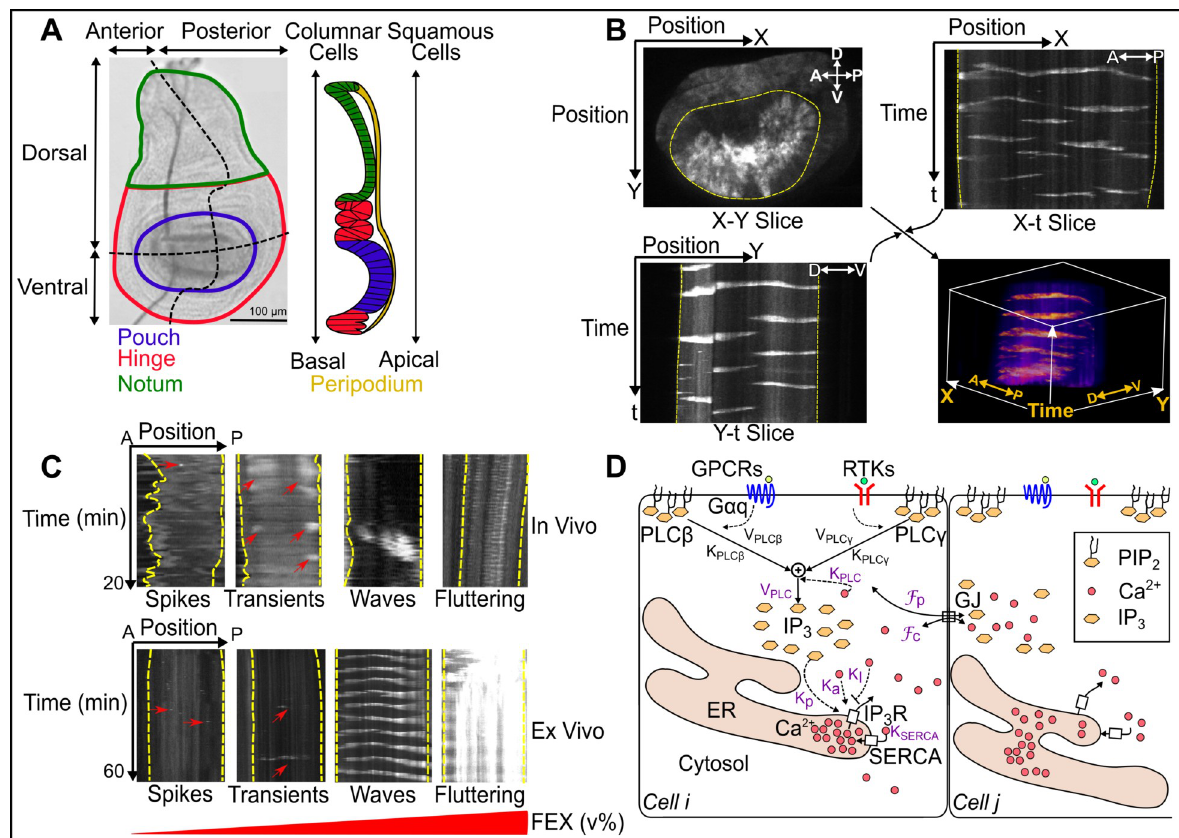
Fig 1. Multicellular Ca 2+ signaling in a developing organ. (A) ( Left panel ) Image of third instar Drosophila wing imaginal disc. The larval wing disc includes main four regions: pouch (blue), hinge (red), notum (green) and peripodium (yellow). The pouch cells are the region of interest for this study. ( Right panel ) A schematic of the side view of the wing disc showing the peripodial membrane composed of squamous epithelial cells. (B) Kymographs illustrate two-dimensional slices of three-dimensional (X, Y and t planes respectively) spatiotemporal signaling. Ca 2+ signaling activity is related to the fluorescence intensity of the Ca 2+ sensor, GCaMP6f. A view of the X-Y plane (top left), the X-t plane (top right), and Y-t plane (bottom left) are combined to illustrate a 3D view of the signaling activity (bottom right). Yellow dashed lines indicate the pouch region. X coordinates roughly correspond to the A/P direction of the wing disc pouch whereas the Y coordinate principally describes the D/V axis of the pouch. (C) Four classes of Ca 2+ signaling patterns are observed both in vivo and ex vivo: single-cell spikes, intercellular transient, intercellular waves and fluttering [19]. In ex vivo cultures, the occurrence of these patterns depend on the concentration of fly extract added to the culture media. Red arrows highlight subtle cellular Ca 2+ activity. (D) Major components of Ca 2+ toolkit: G protein–coupled receptors (GPCRs), receptor tyrosine kinase (RTKs), gap junctions (GJ), Inositol trisphosphate (IP 3 ), diacylglycerol (DAG), Phospholipase C (PLC), Phosphatidylinositol 4,5-bisphosphate (PIP 2 ), sarco/endoplasmic reticulum Ca 2+ -ATPase (SERCA) and IP 3 receptors (IP 3 R). Parameters for our computational model are denoted in purple. K PLC and V PLC values are lumped activity parameters that are describe the stimulus-dependent activity of specific PLC isoforms, specifically PLC γ downstream of the insulin receptor and PLC β downstream of GPCR